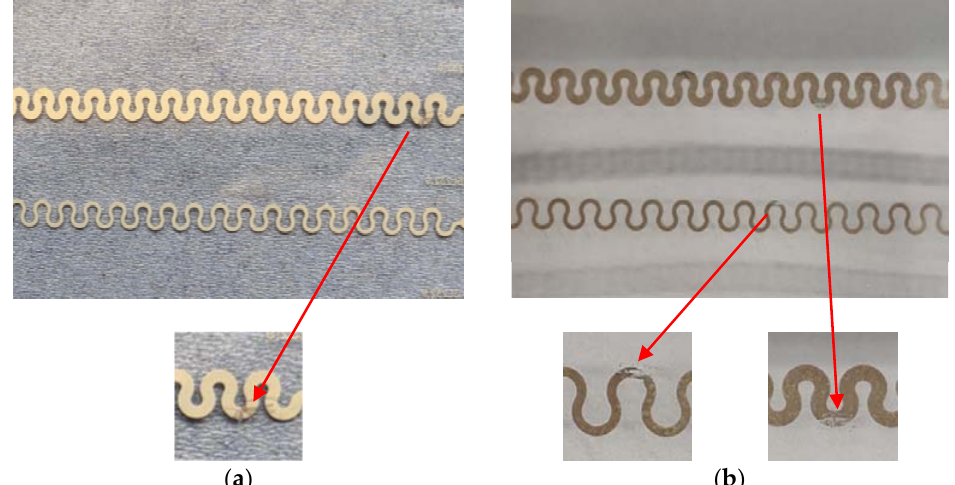
Figure 9. Partial wire breaks on ( a ) Test Sample 3—meander printing pattern with one partial wire break on the third wire; ( b ) Test Sample 4—meander printing pattern test sample with cut through on the fifth wire.